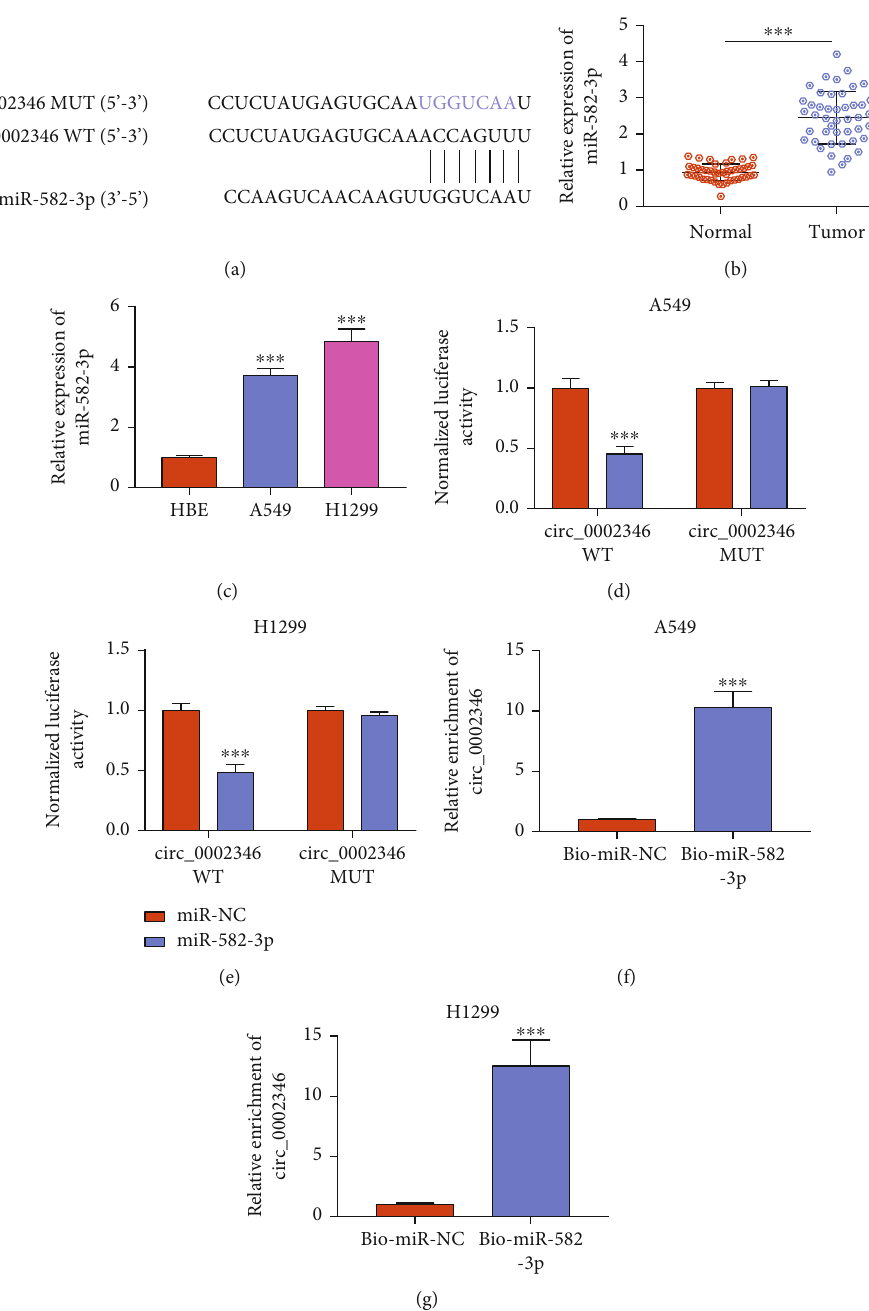
Figure 3: circ_0002346 directly binds to miR-582-3p. (a) The putative binding sites between circ_0002346 and miR-582-3p predicted by Circinteractome are shown. (b) The expression of miR-582-3p in 45 pairs of NSCLC tissues and paracancer tissues was determined by RT-qPCR. (c) The level of miR-582-3p was examined in the NSCLC cell lines and the HBE cell line by RT-qPCR. (d, e) The target relationship between circ_0002346 and miR-582-3p was veri fi ed by a dual-luciferase reporter assay. (f, g) An RNA pull-down assay was performed to con fi rm the interaction between circ_0002346 and miR-582-3p. ∗∗∗ P < 0 : 001